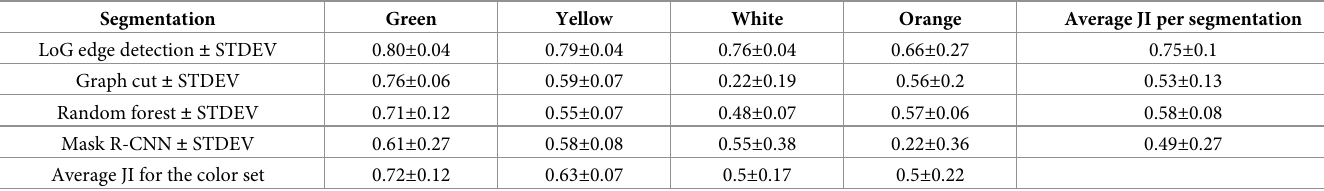
Average JI for the color set The presented values of Jaccard index are the means of the individual indexes obtained for the individual image ± Standard Deviation (STDEV). The original set contained seven images for the each of the four test background colors.